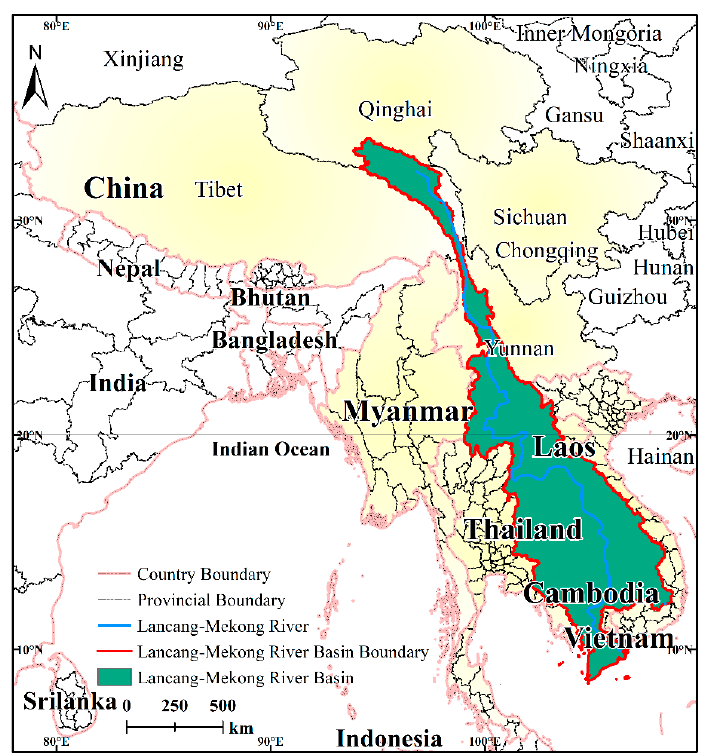
Figure 1. Geographical location of the Lancang-Mekong Region (LMR).